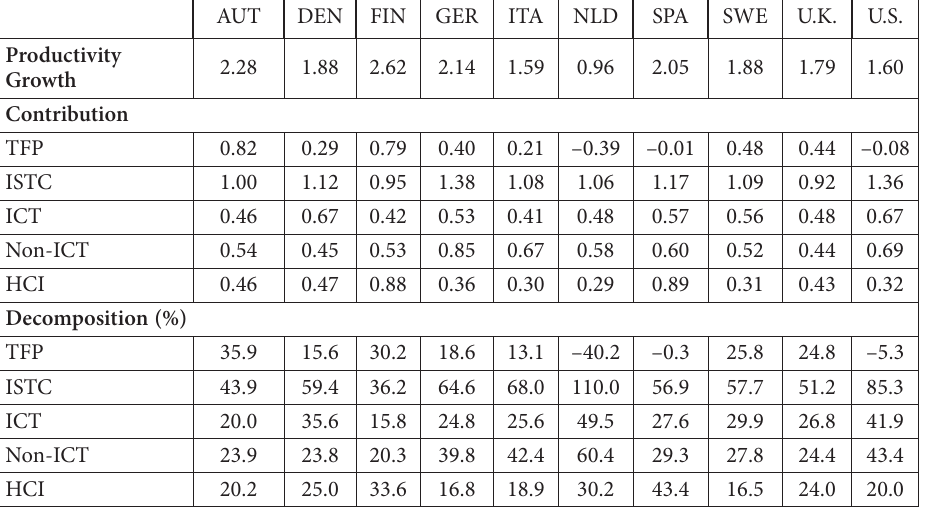
Table 7. Equilibrium Decomposition of Labor Productivity Growth, 1980 – 2010 AUT DEN FIN GER ITA